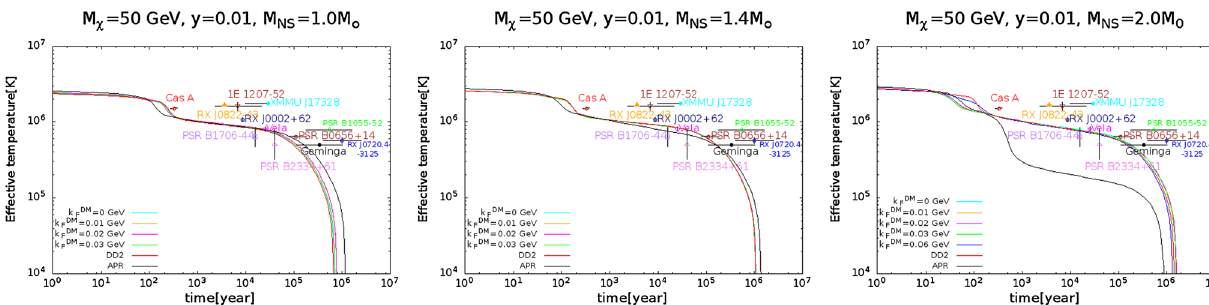
compared with the observational data of pulsars namely Cas A, RX J0822-43, 1E 1207-52, RX J0002+62, XMMU J17328, PSR B1706- and F